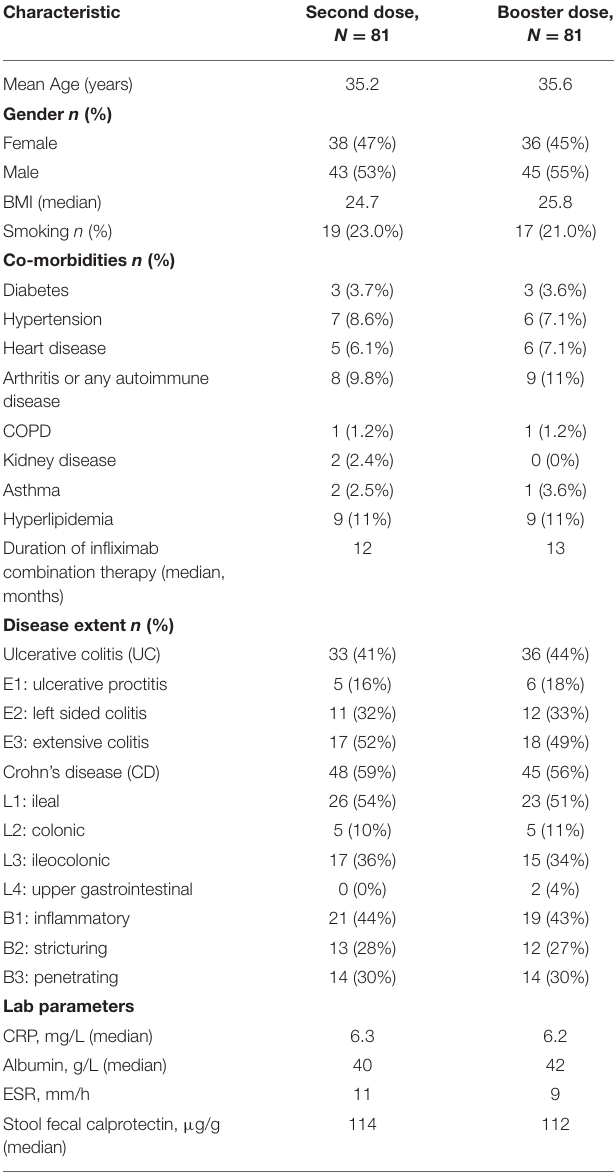
TABLE 1 | Baseline characteristics of